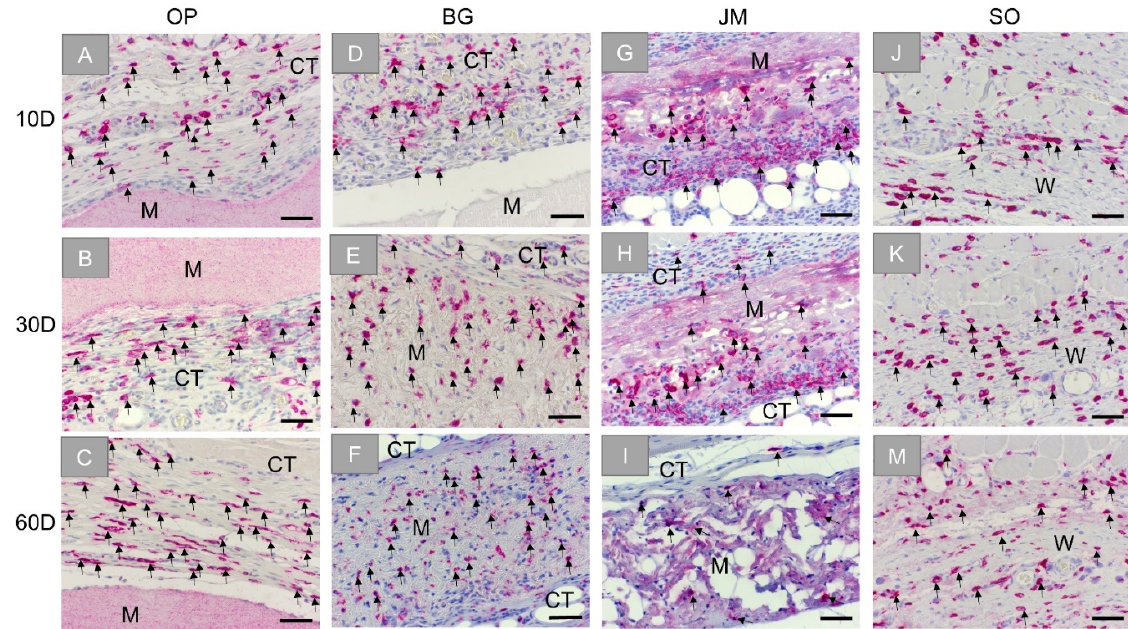
Figure 6. Exemplary images of the immunohistochemical detection of anti-inflammatory M2 macrophages within the bed implants of the different barrier membranes and the sham operation group at three time points: 10 days, 30 days, and 60 days. First column: Ossix ® Plus (OP) ( A – C ), second column: Bio-Gide ® (BG) ( D – F ), third column: Jason ® membrane (JM) ( G – I ), and forth column: sham operation (SO) ( J – M ). CT: connective tissue, M: membrane, W: wound area, black arrows: CD163-positive cells (CD163-immunostainings, 20 × objective magnifications and scalebars = 50 µ